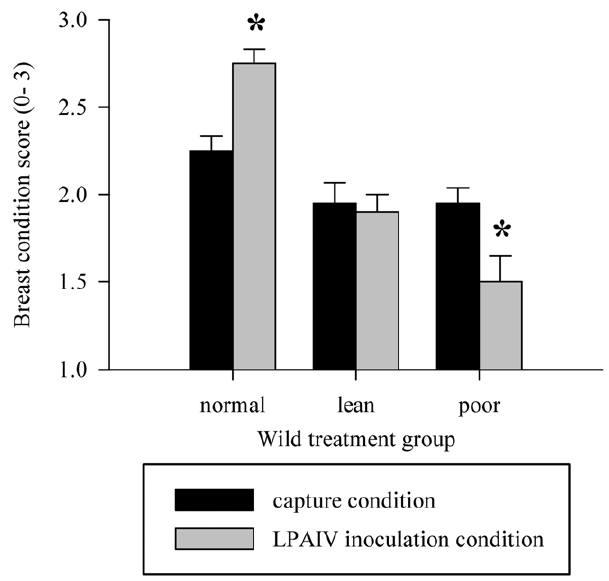
Figure 6. Breast condition score for wild mallard treatment groups at capture vs. LPAIV H5N9 challenge. Bars represent mean condition score 6 1 standard error (n= 10), asterisks represent significant within group differences (paired t-test,